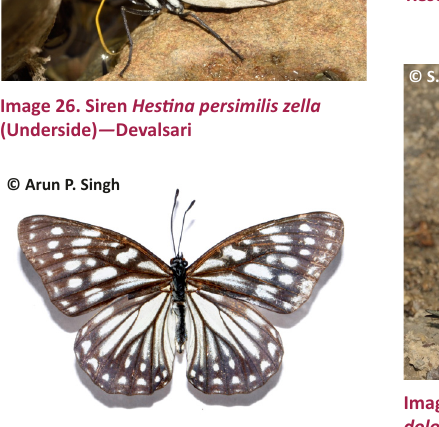
Image 24. Indian Purple Emperor Apatura ambica ambica— Kedarnath Musk Deer Reserve